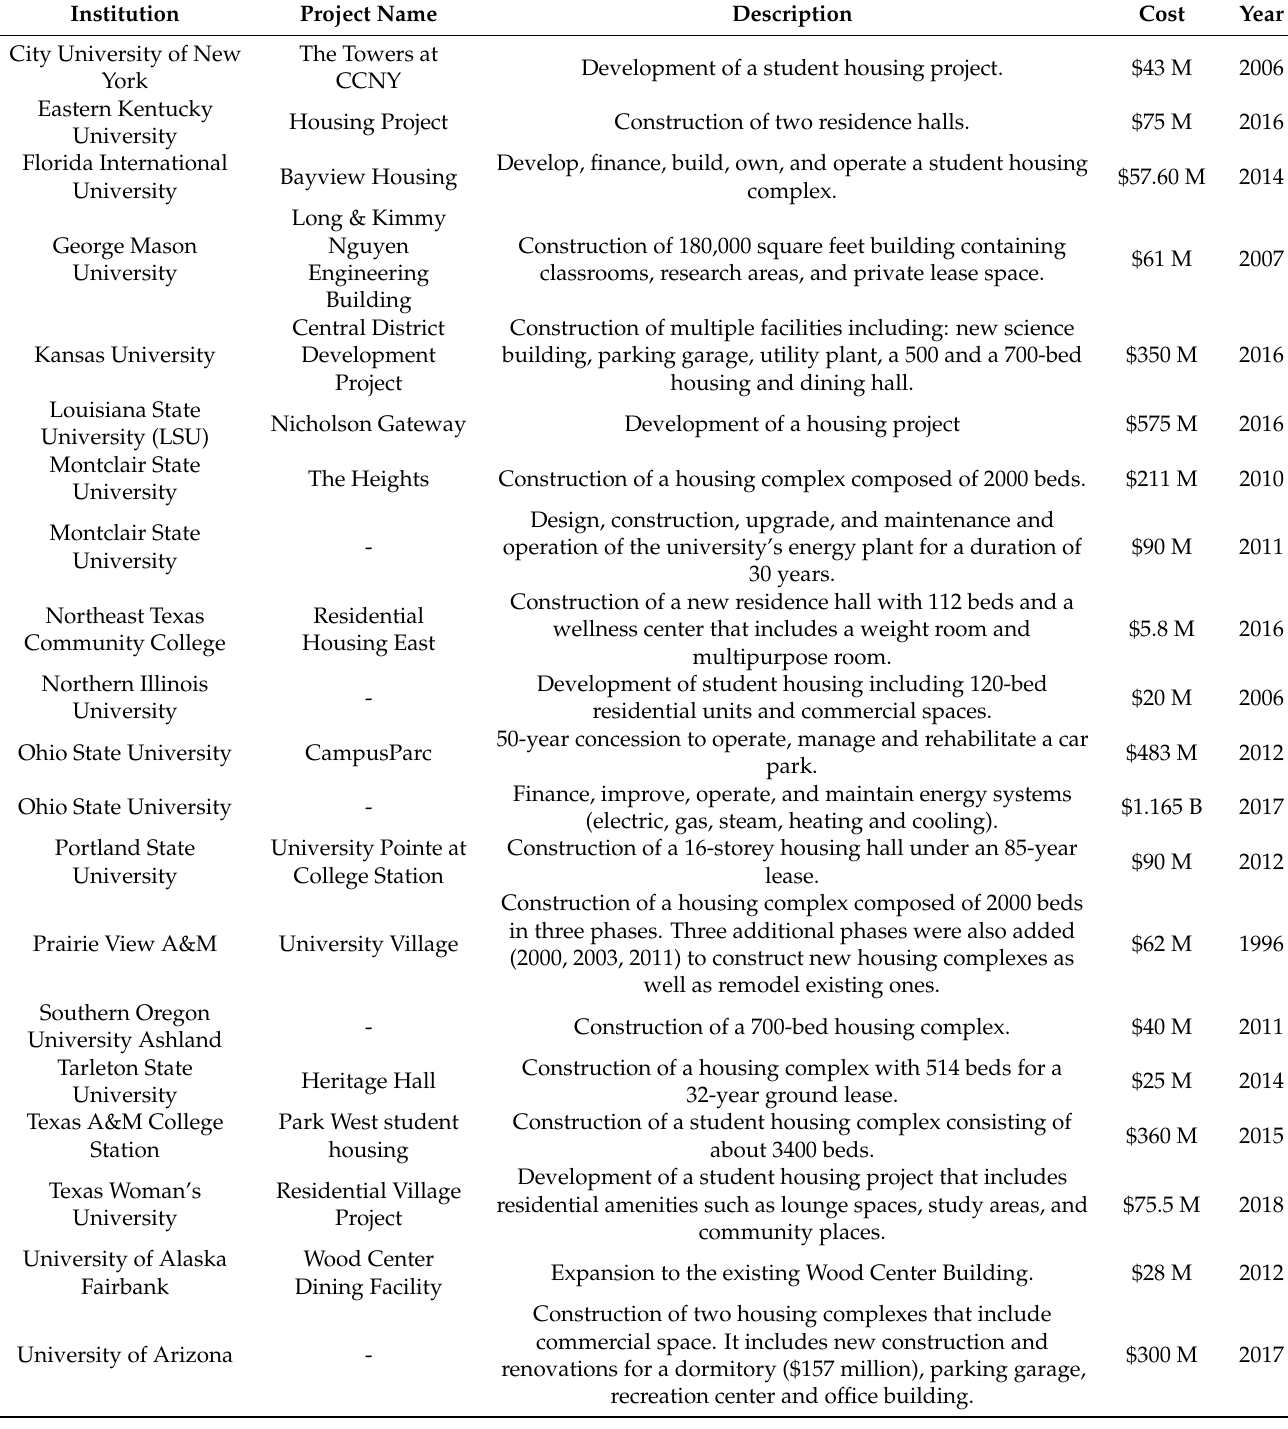
Table 2. List of Identified Higher Education